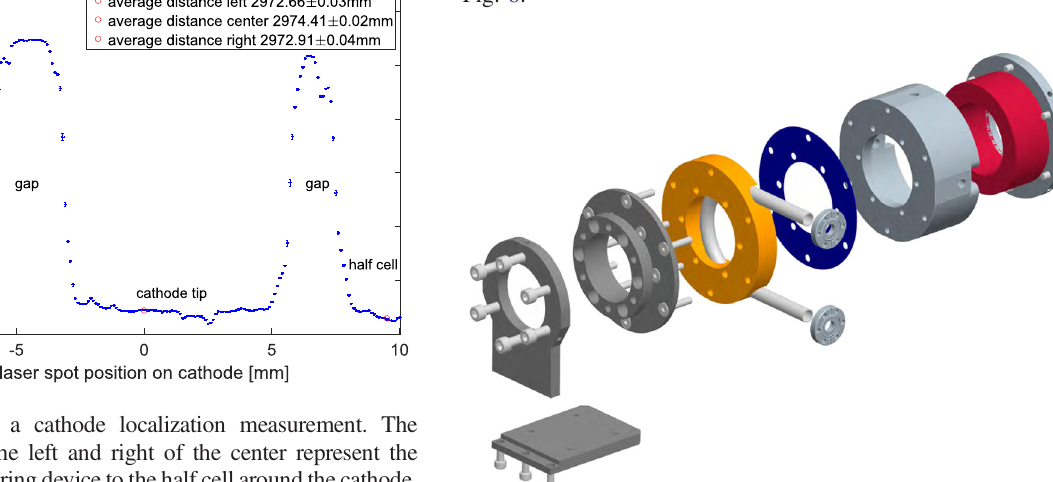
FIG. 6. The 3 − 1 = 2 cell cavity is contained in titanium vessel filled with liquid helium. The SC solenoid is installed around the beam tube in front of the resonator (red circle) and connected to the same helium reservoir supplying the cavity vessel, the connecting lines transporting the liquid helium can be seen in Fig. 8.